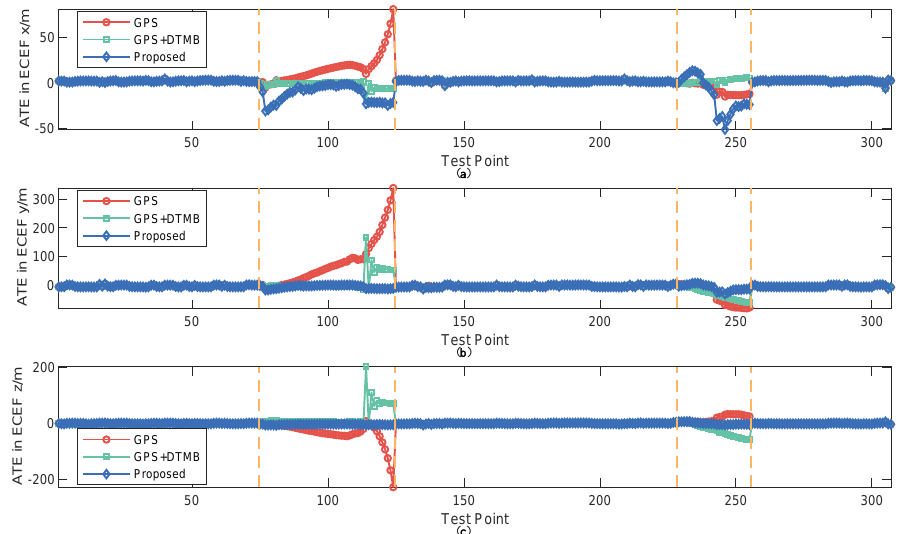
Figure 25. ATE of the three methods at each test point at Site 2: ( a ) ATE in x axis direction of the ECEF system; ( b ) ATE in y axis direction of the ECEF system; and ( c ) ATE in z axis direction of the ECEF